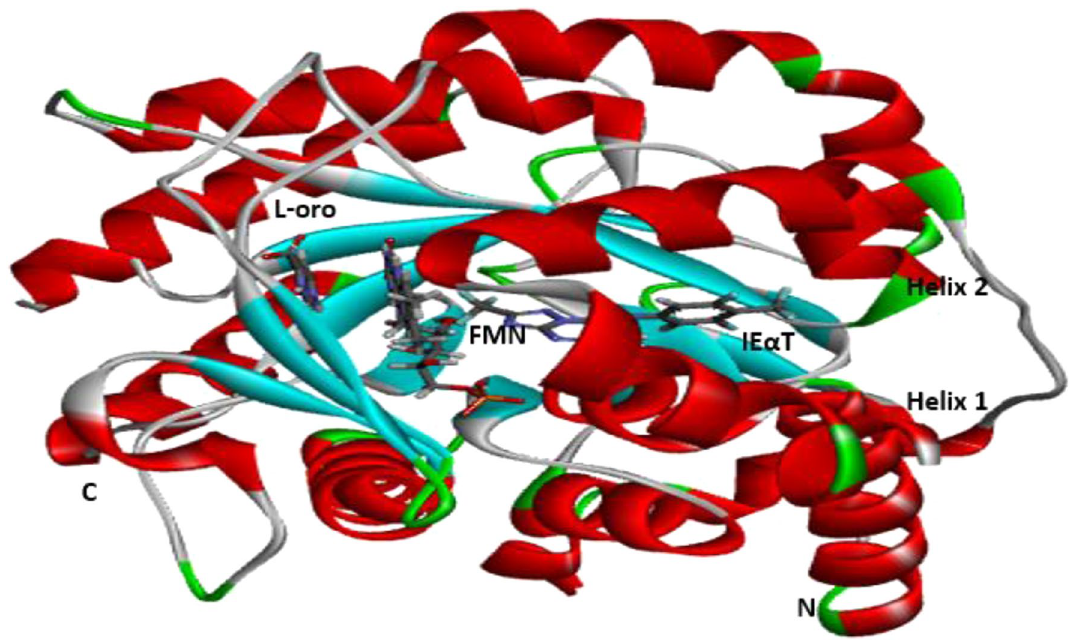
Fig. 4 Ribbon diagram showing the indolyl-3-ethanone-α-thioethers binding site on PfDHODH. Indolyl-3-ethanone-α-thioethers is dis- played as IEαT, FMN, and L-orotate